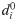
Im9 binding free energies for H1→H2.(A) Binding free energies, ΔGbind, for the association of H1 and H2 with native and nonnative packing angles. Nonnative configurations are generated by rotating H1 (filled black circles), or H2 (open red squares), or changing the H1-H2 crossing angle (filled blue triangles). ΔGbind is computed from the total Boltzmann-weighted H1-H2-distance-dependent population of the entire free-energy basin (thus it correlates with but is not necessarily equal to the minimum PMF value; see S1 Text). (B) PMFs here are distance-dependent free energies for the association of H1 and H2 in native (black curve) and nonnative orientations with H1 targeted to be rotated by +30° (blue curve) or −30° (red curve). Actual rotation angles sampled during the computations of these PMFs are close to the targets (S3 Fig). Standard deviations of the mean from block averaging are shown as vertical bars in (A) or shaded regions in (B). (C) Two-dimensional PMF of the H1, H2 packing angles in simulations with helical rotation but no change in H1-H2 crossing angle. Data are drawn from multiple simulations, including one started and restrained to the native orientation and twenty others with preferred nonnative packing angles in which one helix is rotated by ±10–50°. Each free energy value (bottom color scale) plotted is the minimum of the distance-dependent PMF for a given inter-helix geometry (S1 Text). White regions have no sampling. By construction, the H1-H2 distance at the minimum of PMF can be different for different rotation angles (see example in S4 Fig). It is noteworthy that the two free-energy basins exhibited here are nonetheless robustly observed at essentially the same packing angles in multiple restrained simulations wherein inter-helical distances are targeted at a given di0 ranging from 1.0 nm to 1.3 nm (S5 Fig).